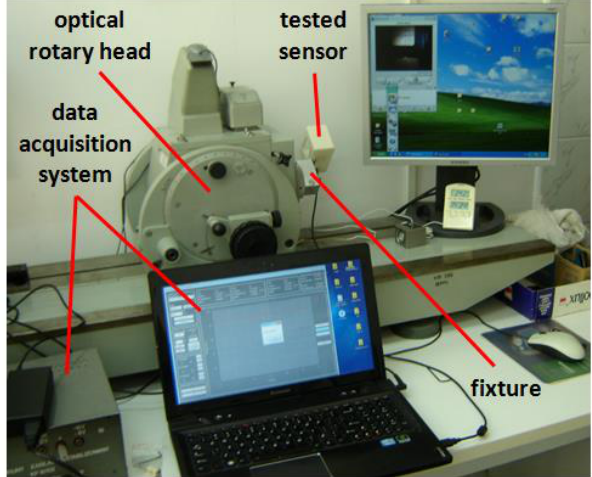
Figure 5. Experimental test rig during the alignment procedure.